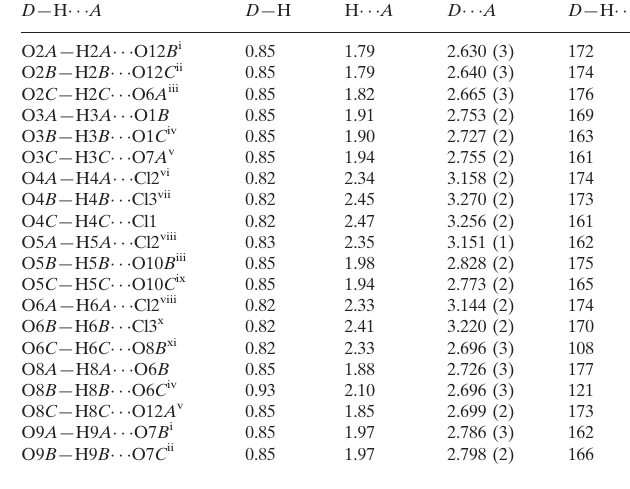
Hydrogen-bond geometry (A˚ , (cid:5)